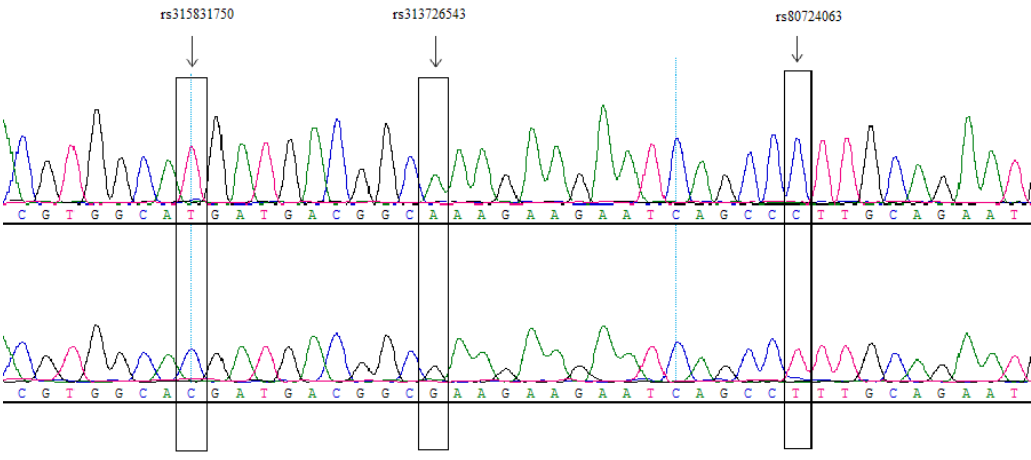
Figure 1. Sequencing analysis of the Perilipin ( PLIN1 ) gene. Arrows indicate mutation